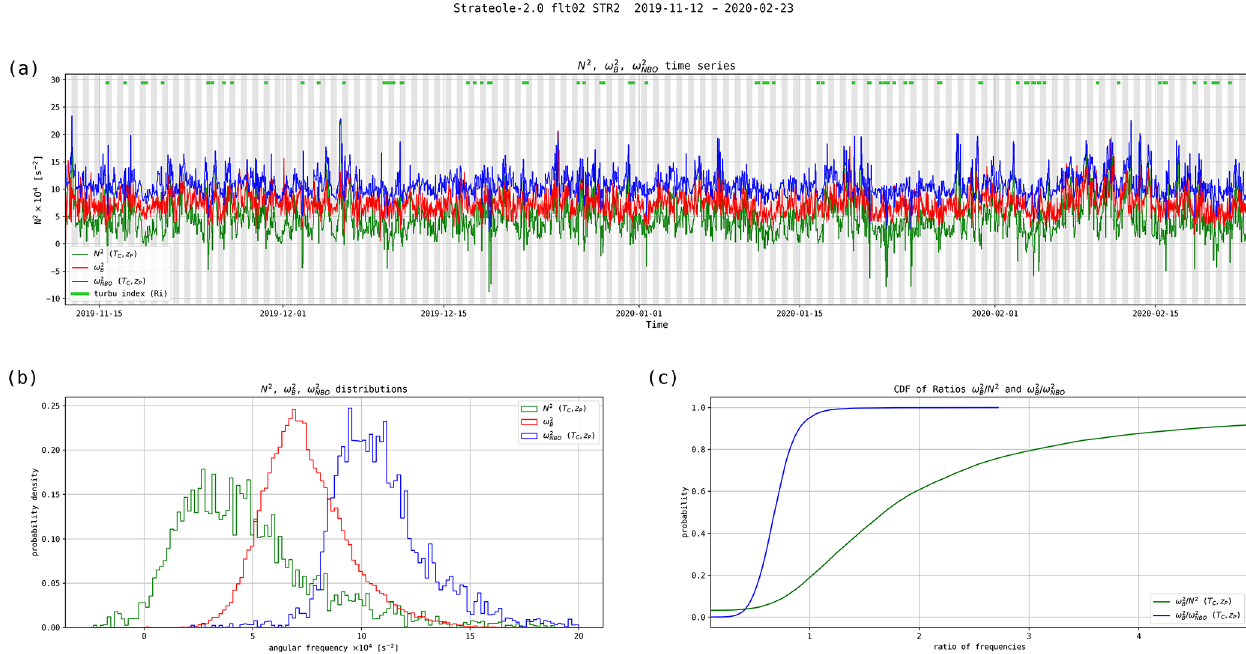
Figure 11. Times series (a) and histograms (b) of the Brunt–Väisälä, NBO, and observed balloon frequencies. The Brunt–Väisälä and NBO frequencies are deduced from the estimates of ∂T/∂z from Cov (δT C ,δz P ). (c) CDF of the ω 2